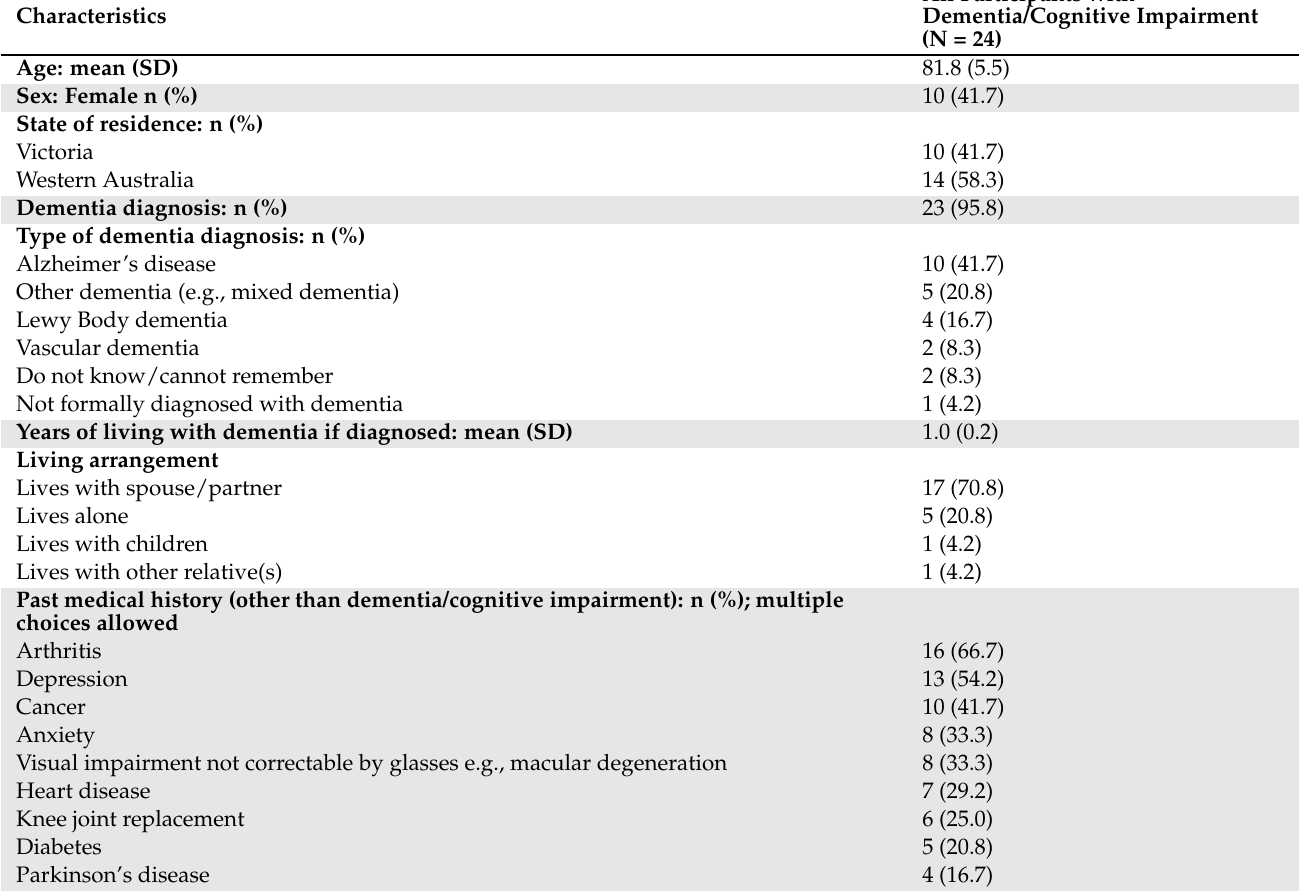
Table 1. Participant demographics/characteristics at week 1.